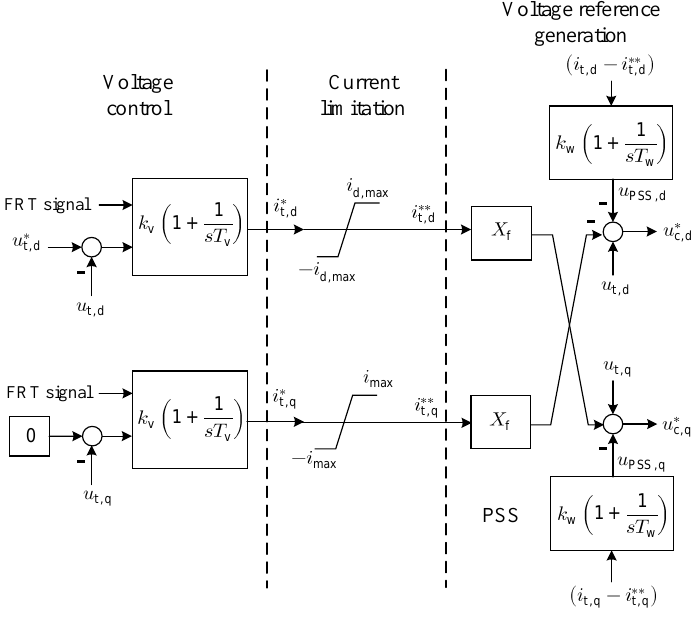
Figure 13. Voltage control, current limitation and voltage reference